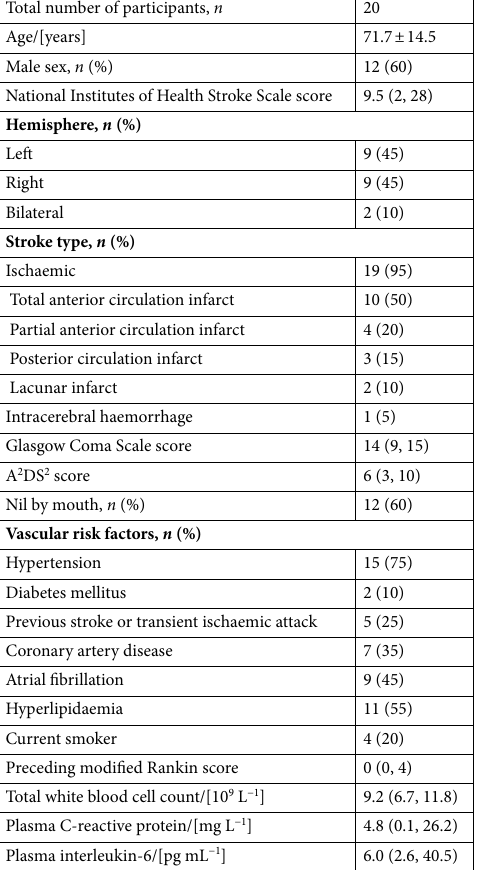
Table 1. Baseline characteristics of the participating patients. Data shown as mean ± SD or median (min, max) except where indicated; A 2 DS 2 score: Age, Atrial Fibrillation, Dysphagia, Sex, stroke